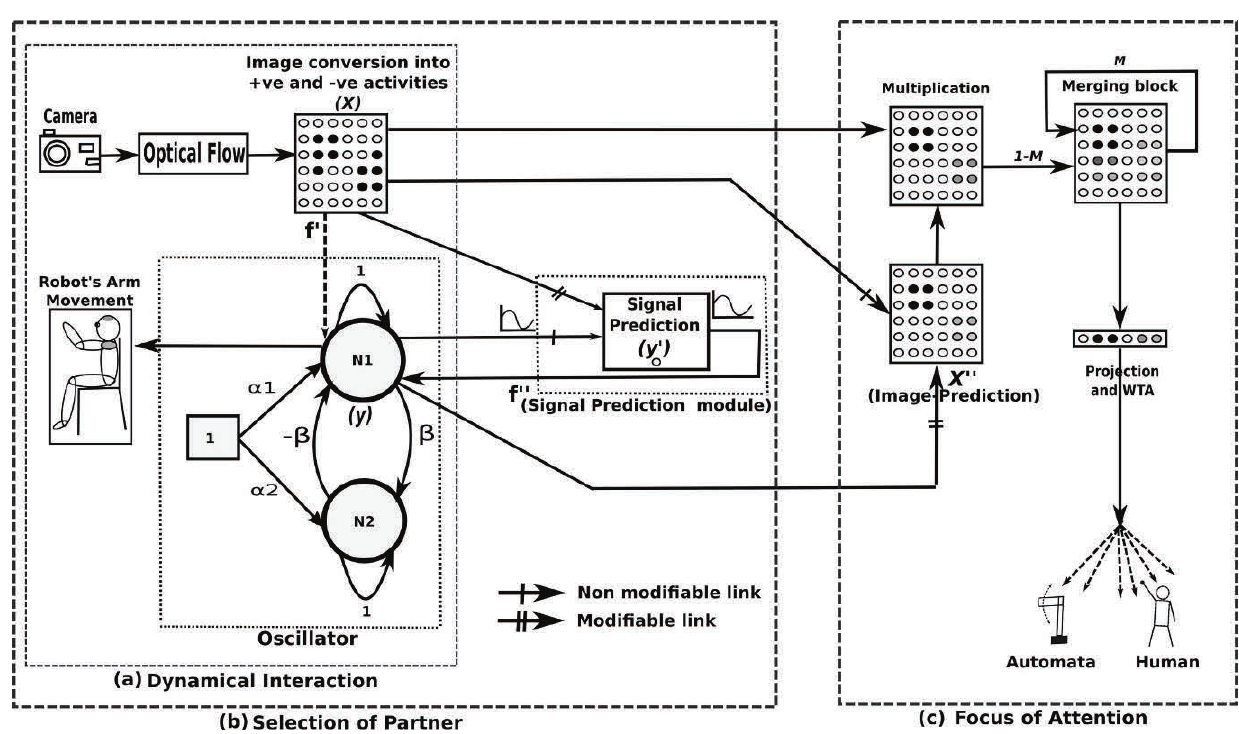
Figure 7. The global architecture (a) Dynamical Interaction model (b) Selection of Partner: select an interacting partner on the basis of synchrony detection among various interacting agents. (c) Focus of Attentional: this architecture capable of locating and pointing the synchronized interacting agent defined by the selection of partner algorithm.